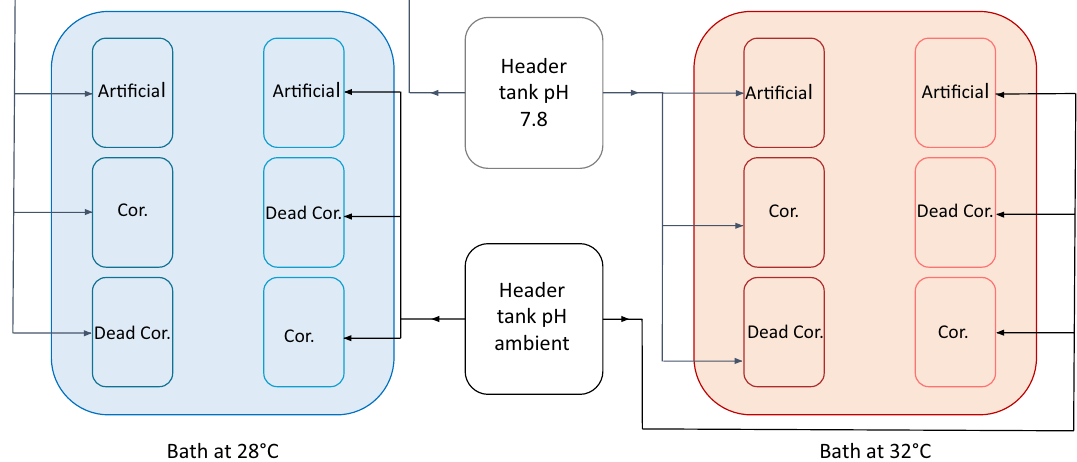
Figure 6. Experimental set-up used to test the effects of temperature (28 and 32 °C), pH (ambient 8.07, and low 7.8) and species facilitation (artificial, coralline and dead coralline substrates) on the recruits of C. compressa . The experimental set-up was repeated 4 times, resulting in 8 header tanks, and 48 experimental tanks in which the different types of substrates were randomly